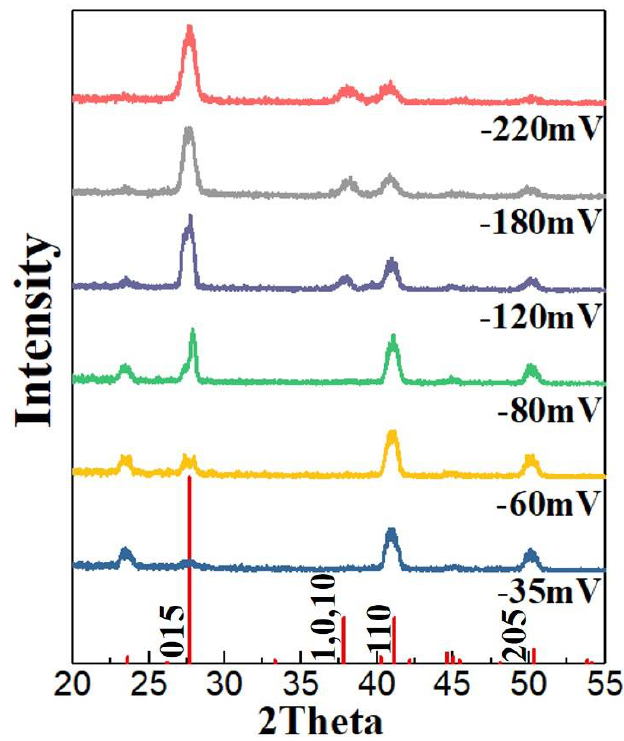
Figure 5. XRD di ff raction patterns of the thin films obtained with di ff erent potentials in the electrolyte Figure 5. XRD diffraction patterns of the thin films obtained with different potentials in the electrolyte containing 7.5 mM Bi and 10 mM containing 7.5 mM Bi and 10 mM Te.